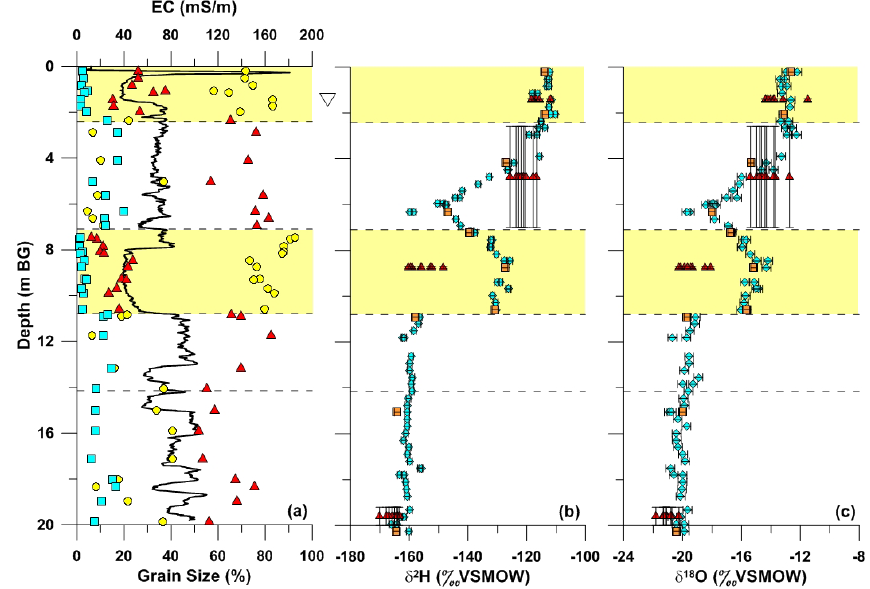
Figure 1. High-resolution profiles vs. metres below ground for (a) percent sand, silt, and clay and electrical conductivity (EC; measured using a direct push EC log), (b) δ 2 H, and (c) δ 18 O near Lethbridge, Alberta, Canada. The sand, silt, and clay size fractions in (a) are presented as yellow circles, red triangles, and light blue squares, respectively. The vapour, mechanical squeezed, and piezometer values in (b) and (c) are presented as blue diamonds, orange squares, and red triangles, respectively. The vertical lines for the piezometer values represent the length of the sand pack around the screened zone. The location of the water table is presented as an inverted triangle in (a) . Gravimetric water content of all samples ranged from 18 to 32% ( n = 59). Yellow shaded areas represent sand